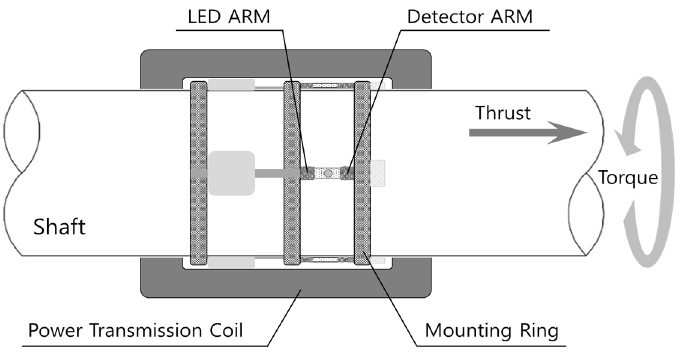
Figure 4. Configuration of the optical measurement system.